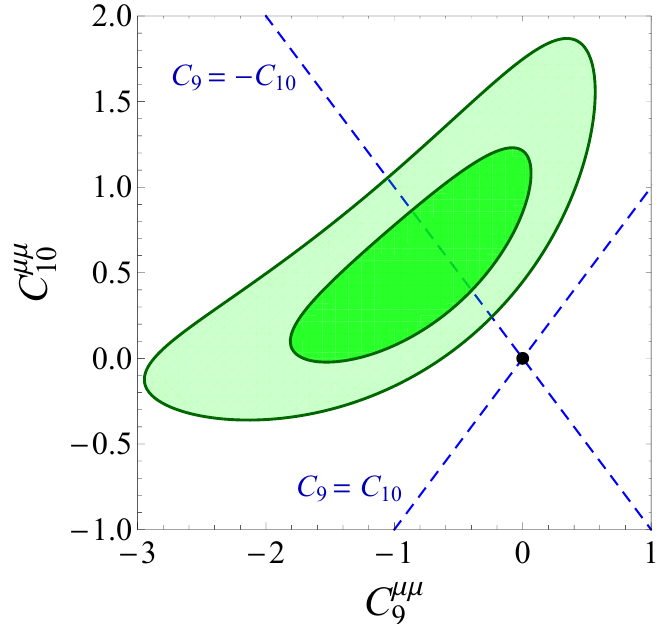
Figure 1 . Low-energy (cid:12)t to R K , R K (cid:3) and B ( B s ! (cid:22)(cid:22) ) in the plane C (cid:22)(cid:22) region is allowed to 1 (cid:27) (2 (cid:27) ) accuracy. Blue dashed lines correspond to scenarios with C (cid:22)(cid:22) while the black dot denotes the SM